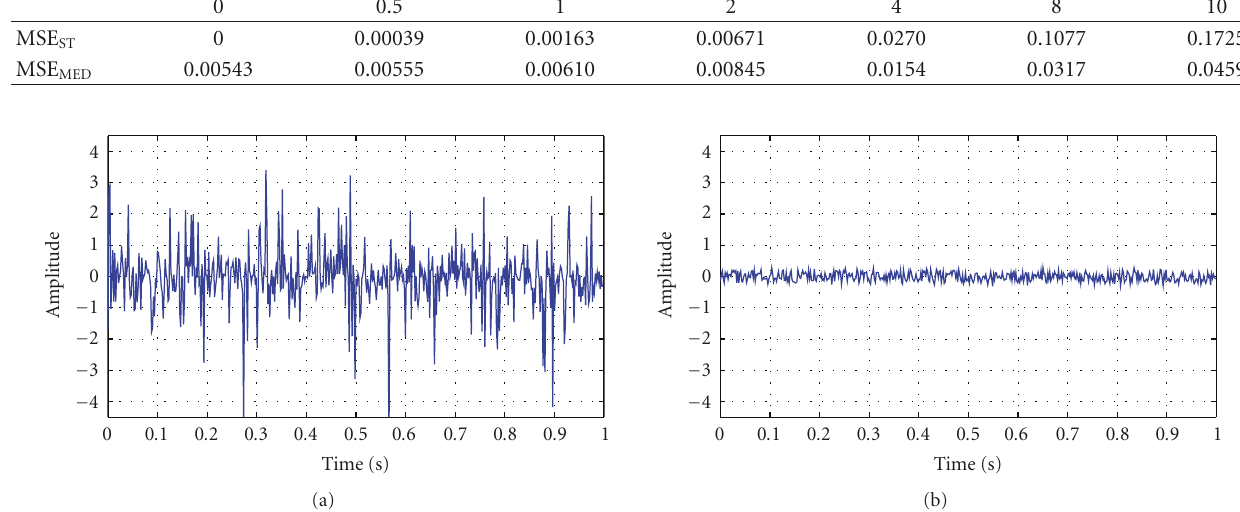
Figure 6: The realization of the original heavy-tailed noise ( σ G = 1) and its estimate obtained after inverse DFT of (cid:2) X MED ( p ) .